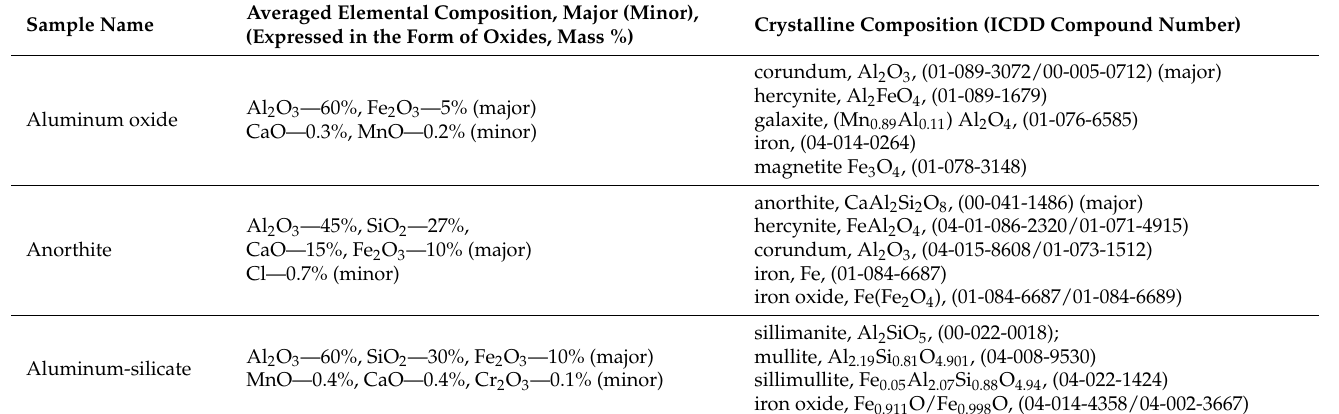
Table 1. Elemental and crystalline compositions of the samples before exposure tests.